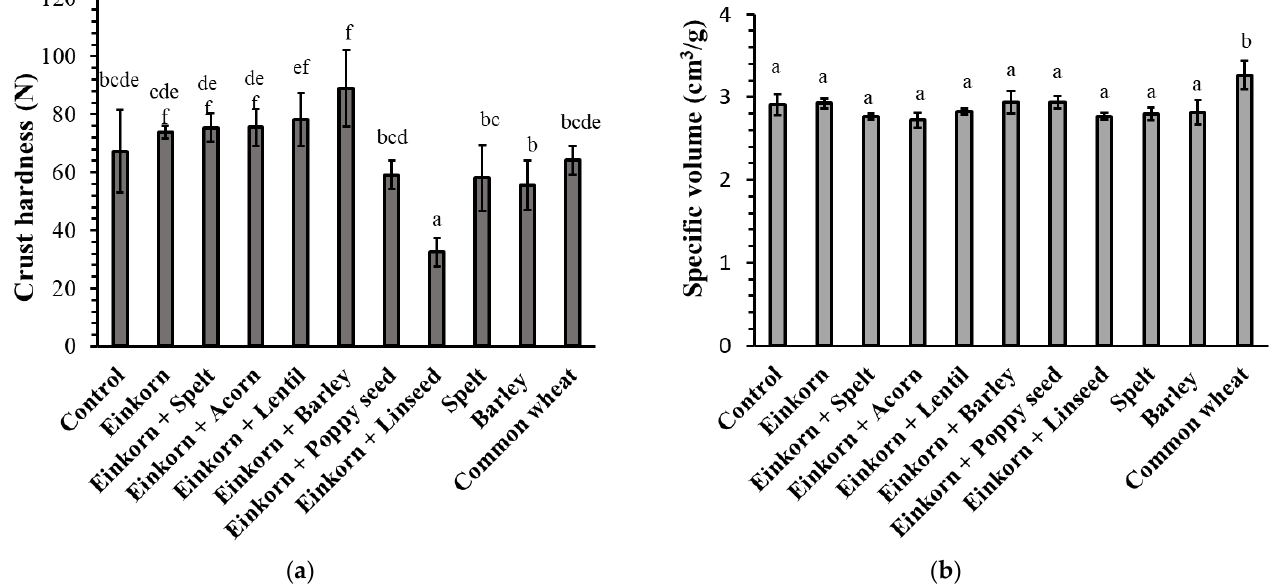
Figure 7. Crust hardness ( a ) and specific volume ( b ) of breads; control formulation is einkorn bread without sourdough. Values followed by the same letter are not significantly different ( p > 0.05, Tukey’s test); notation of samples as in Table 1.